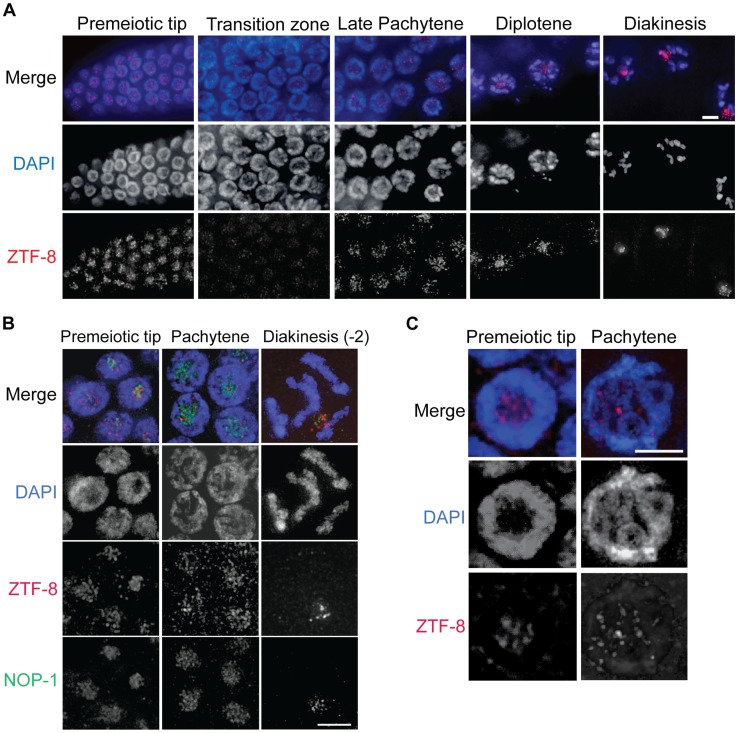
ZTF-8 is expressed in both mitotic and meiotic nuclei.
A. Immunolocalization of ZTF-8 in whole mounted gonads utilizing a C-terminal peptide purified antibody against ZTF-8. Bar, 4 µm. B. Co-immunostaining with NOP-1, which encodes for a small nucleolar fibrillarin protein, reveals that ZTF-8 is enriched at the nucleolus. C. Localization of ZTF-8 at DAPI-stained chromosomes. At the premeiotic tip, 34% of ZTF-8 foci are localized to DAPI-stained chromosome. At late pachytene, 78% of ZTF-8 foci localize to DAPI-stained chromosomes (n = 102 nuclei at the premeiotic tip, 53 nuclei at pachytene, from 7–10 gonads). Bars, 2 µm.